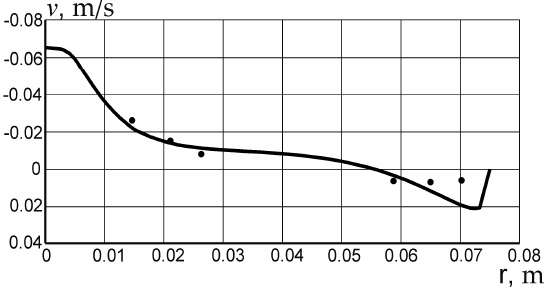
Figure 11. Graph of the velocity distribution along its radius at Z = − 221 mm ( —- calculation; • • experiment [14]).